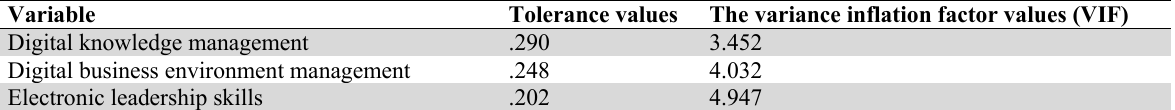
The variance inflation factor values and tolerance values of the dimensions of the independent variable (i.e. digital entrepre- neurship)